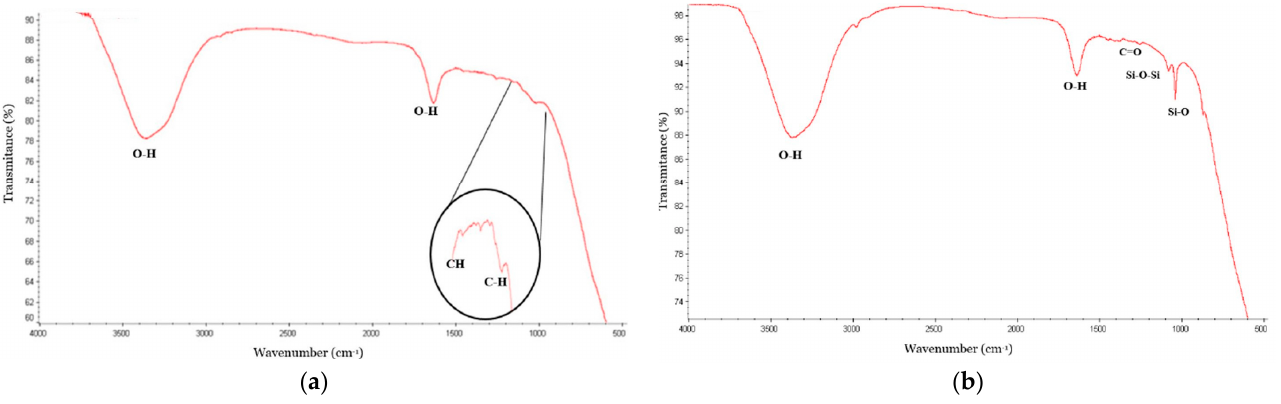
Figure 3. FTIR spectrum of ( a ) the AuNPs coated with PEG, showing the O-H and C-H vibrations bands at 3350 to 3490 cm − 1 and 1630 to 1750 cm − 1 , which correspond to the O-H flexion and stretching vibrations, respectively, and ( b ) the FTIR spectrum of the AuNPs coated with silica, where the bands at 1100, 1300, 800, and 1000 cm − 1 correspond to Si-O-Si and Si-O bond vibrations.